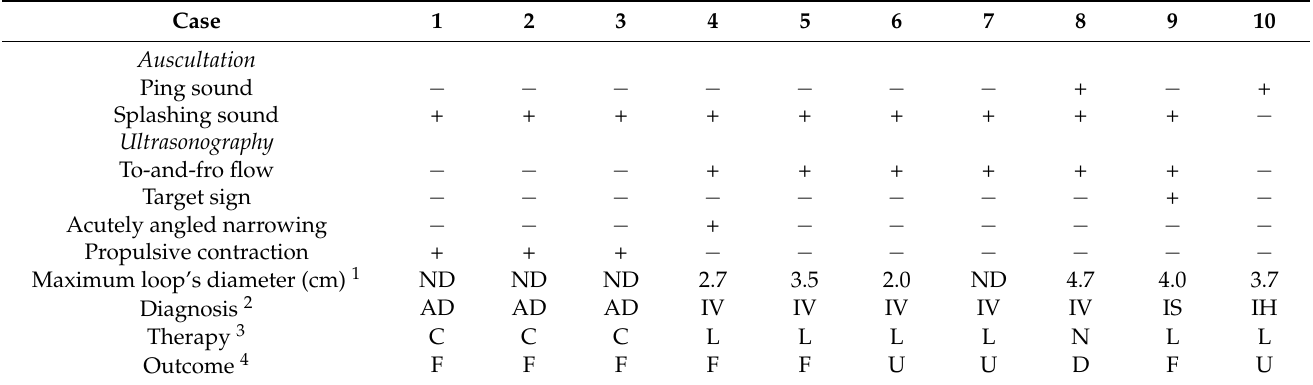
Figure 1. Macroscopic views of the abdomens of Case 2 ( A ), Case 4 ( B ), Case 8 ( C ), and Case 9 ( D ). ( A ) Abdominal distention is evident in the ventral region of the right flank. ( B ) Abdominal distention is not 3 Conservation therapy, laparotomy, and non-treatment are abbreviated as C, L, and N respectively. 4 E Favorable evident in either flank of the depressed, laying-down calf. ( C ) In the dorsal view, abdominal distention and unfavorable outcomes, and sudden death are abbreviated as F, U, and D respectively. Each clinical sign is evaluated as being which of detected (+) and undetected ( − ). is markedly evident in both flanks. ( D ) Abdominal distention is not evident in either flank.